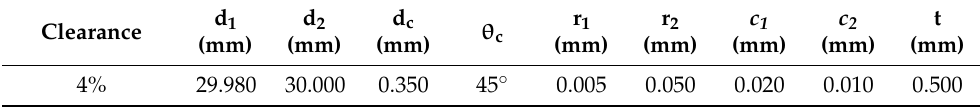
Figure 2. Geometric illustration of the punching experiment. ( d 1 is the radius of the punch; d 2 is the inner diameter of the die; d c is the chamfer distance of the punch; θ c is the chamfer angle of the punch; r 1 is the fillet radius of the blank holder; r 2 is the fillet radius of the die; c 1 is the difference value in radius between the punch and blank holder; c 2 is the difference value in radius between the punch and die; t is the thickness of the silicon sheet). Table 2. Dimensions corresponding to the geometric illustration in Figure